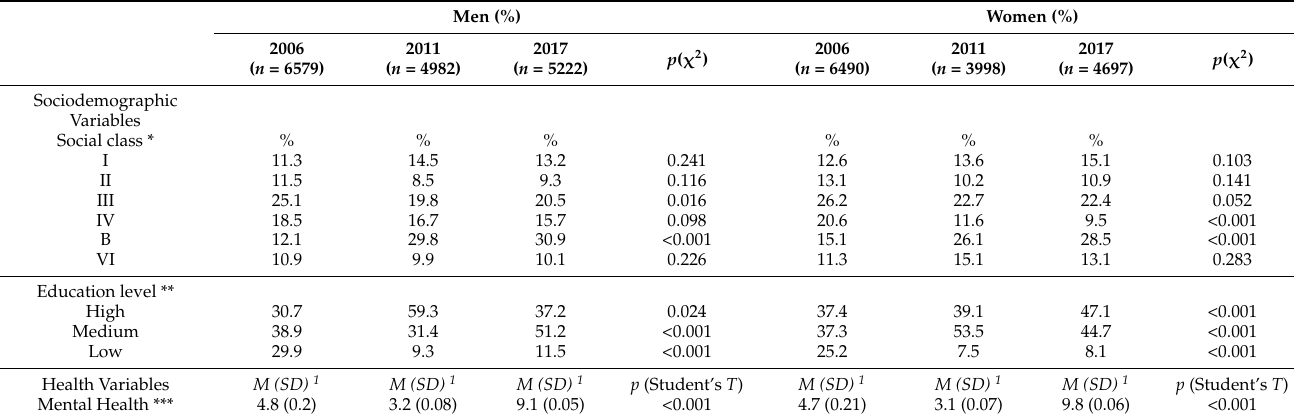
Table 1. Description of the sociodemographic and health (mental health) characteristics of the working population. Disaggregated by sex. Spain (2006–2017).